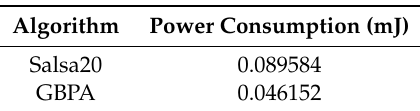
Table 8. Power consumption comparison between Salsa20 and